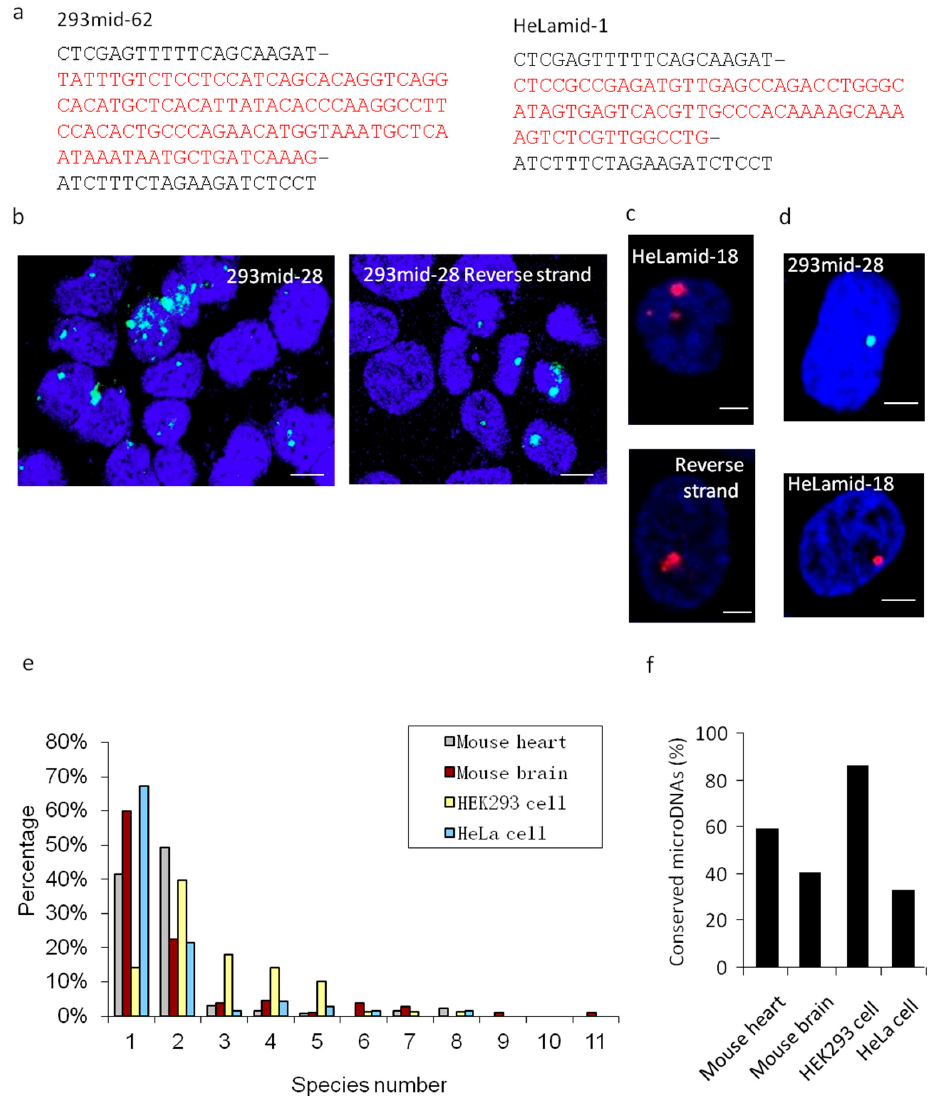
Figure 4. Determination of microDNA subcellular localization and conservation level. ( a ) The sequencing data of 293mid-62 and HeLamid-1 in the detection of endogenous linear microDNAs. The 293mid-62 probe with a biotin tag at the 5 (cid:48) -end was transfected into HEK293 cells, and HeLamid-1 probe with a biotin tag at the 5 (cid:48) -end was transfected into HeLa cells. Then the pulldown system based on interaction between biotin and streptavidin was performed and the 293mid-62 and HeLamid-1 were detected by sequencing. ( b , c ) Detection of SSLmicroDNA subcellular localization. HEK293 cells were transfected with 293mid-28 or its reverse strands labeled with a FAM at the 5 (cid:48) -end ( b ), and HeLa cells were transfected with HeLamid-18 or its reverse strands labeled with a TAMRA at the 5 (cid:48) -end ( c ). The nuclei were stained by DAPI (the dark blue area). The light blue dots represented 293mid-28 or its reverse strands. The red dots represented HeLamid-18 or its reverse strands. The Bar = 10 µ m. ( d ) Fluorescence in situ hybridization (FISH) analysis of SSLmicroDNA localization in cell nucleus. 293mid-28 was detected by its probes labeled with FAM at the 5 (cid:48) -end in HEK293 cell nucleus. HeLamid-18 was detected by its probes labeled with TAMRA at the 5 (cid:48) -end in HeLa cell nuclei. The nuclei were stained by DAPI (the dark blue area). The light blue dots represented 293mid-28. The red dots represented HeLamid-18. Bar = 20 µ m. ( e ) Analysis of the conservation level of SSLmicroDNA sequences. Species number represents the number of species in which SSLmicroDNAs were conserved. f, Summary of the conservation level of SSLmicroDNAs. The SSLmicroDNAs that were conserved in more than one species were